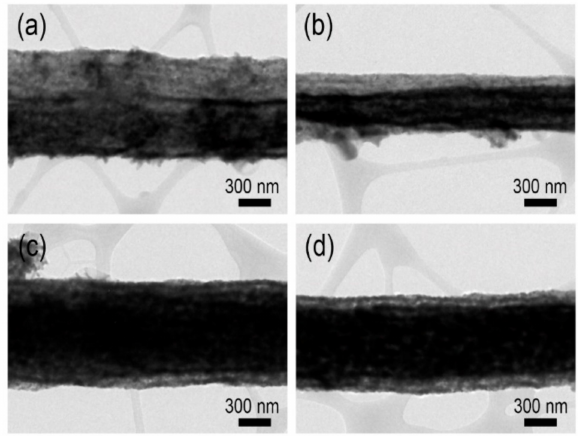
Figure 1. Scanning electron microscopy (SEM) images of ZnO nanofibers prepared at di ff erent annealing temperatures for 4 h: ( a ) 400 ◦ C; ( b ) 500 ◦ C; ( c ) 600 ◦ C; ( d ) 700 ◦ C.